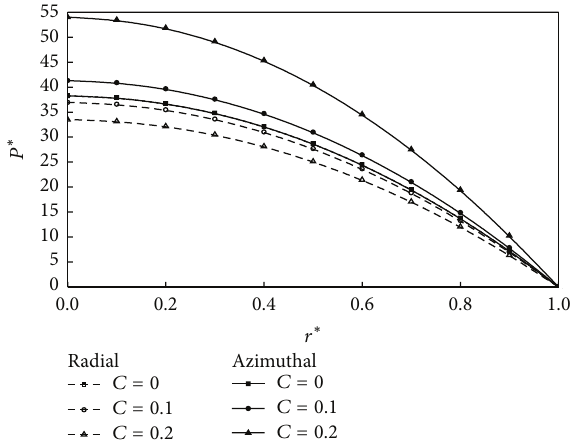
Figure 2: Variation of nondimensional pressure 𝑃 ∗ with 𝑟 ∗ for different values of 𝐶 with 𝑀 0 = 3 , 𝑙 ∗ = 0.3 , and 𝐻 ∗ = 0.4 .